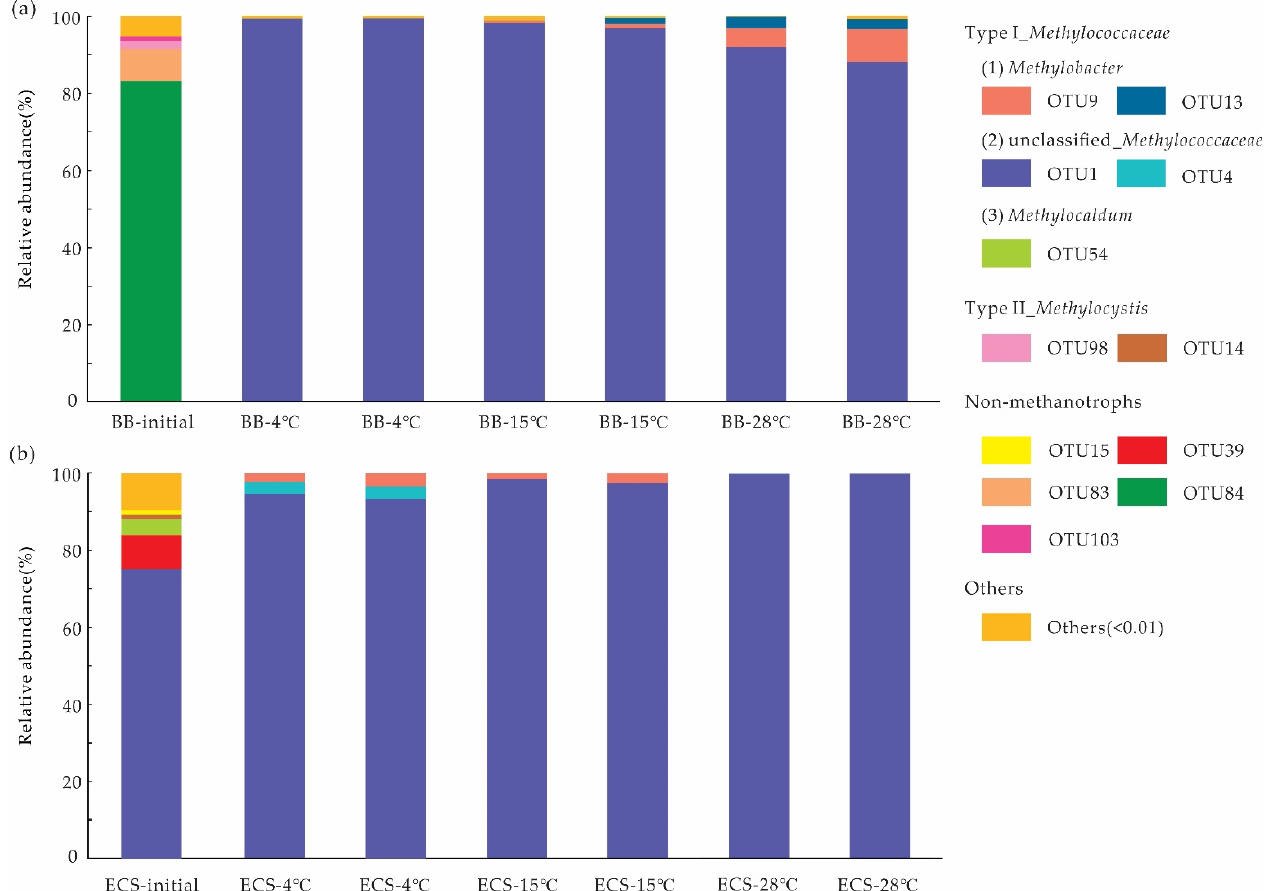
Figure 3. Taxonomic composition of methanotrophic communities in sediment samples from BB ( a ) and ECS ( b ).